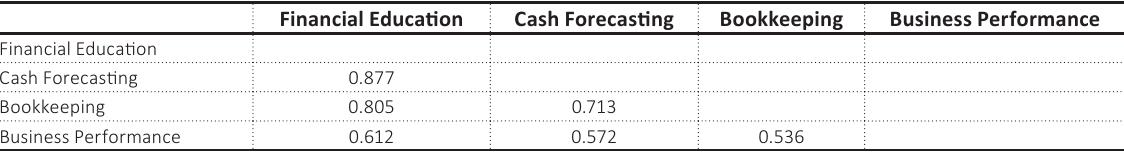
Table 5. Hypothesis testing results